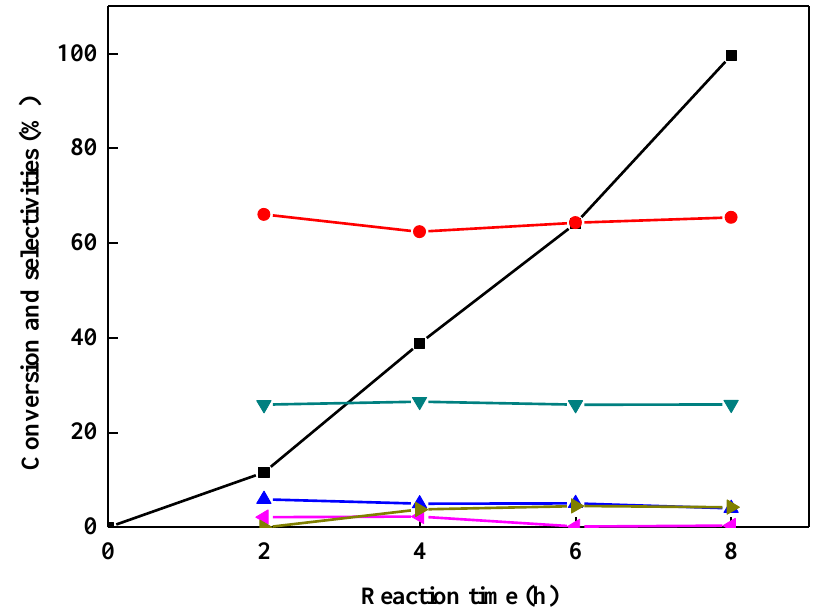
Figure 5. Chlorination of toluene with gaseous Cl 2 over the [BMIM]Cl-2ZnCl 2 ionic liquid catalyst at different reaction times. ■ , conversion of toluene; ●, selectivity of o -chlorotoluene; ▲ , selectivity of m -chlorotoluene; ▼ , selectivity of p -chlorotoluene; ◄ , selectivity of benzyl chloride; ► , selectivity of dichlorotoluenes. Reaction conditions: toluene, 0.5 mol; chlorine, 25 mL min −1 ; [BMIM]Cl-2ZnCl 2 , 3 mol/100 mol toluene; reaction temperature, 80 °C.